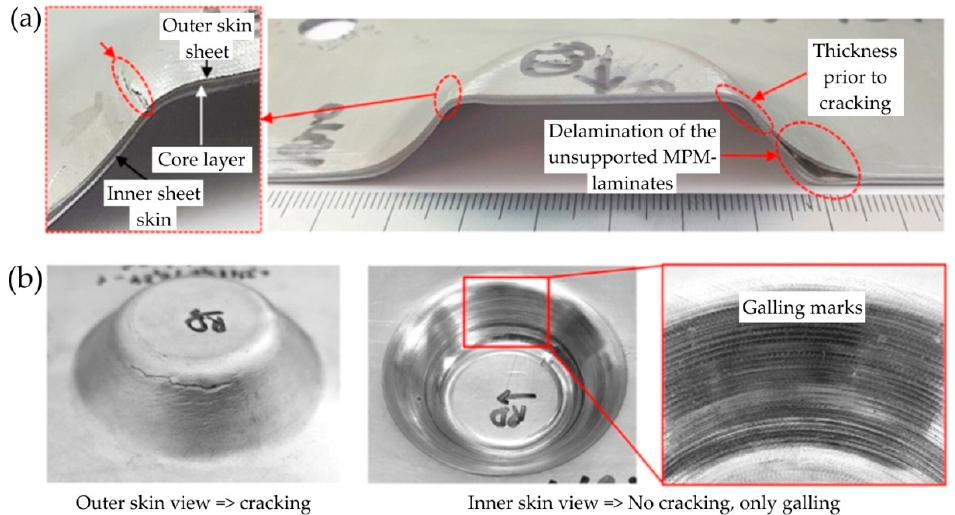
Figure 21. Defects during SPIF of metal–polymer–metal (MPM) sandwich sheets: ( a ) delamination and ( b ) cracking of the outer skin sheet and galling marks in the inner surface of the formed part, reproduced from [278] (this is an open access article distributed under the terms of the Creative Commons CC-BY license, which permits unrestricted use, distribution, and reproduction in any medium, provided the original work is properly cited).